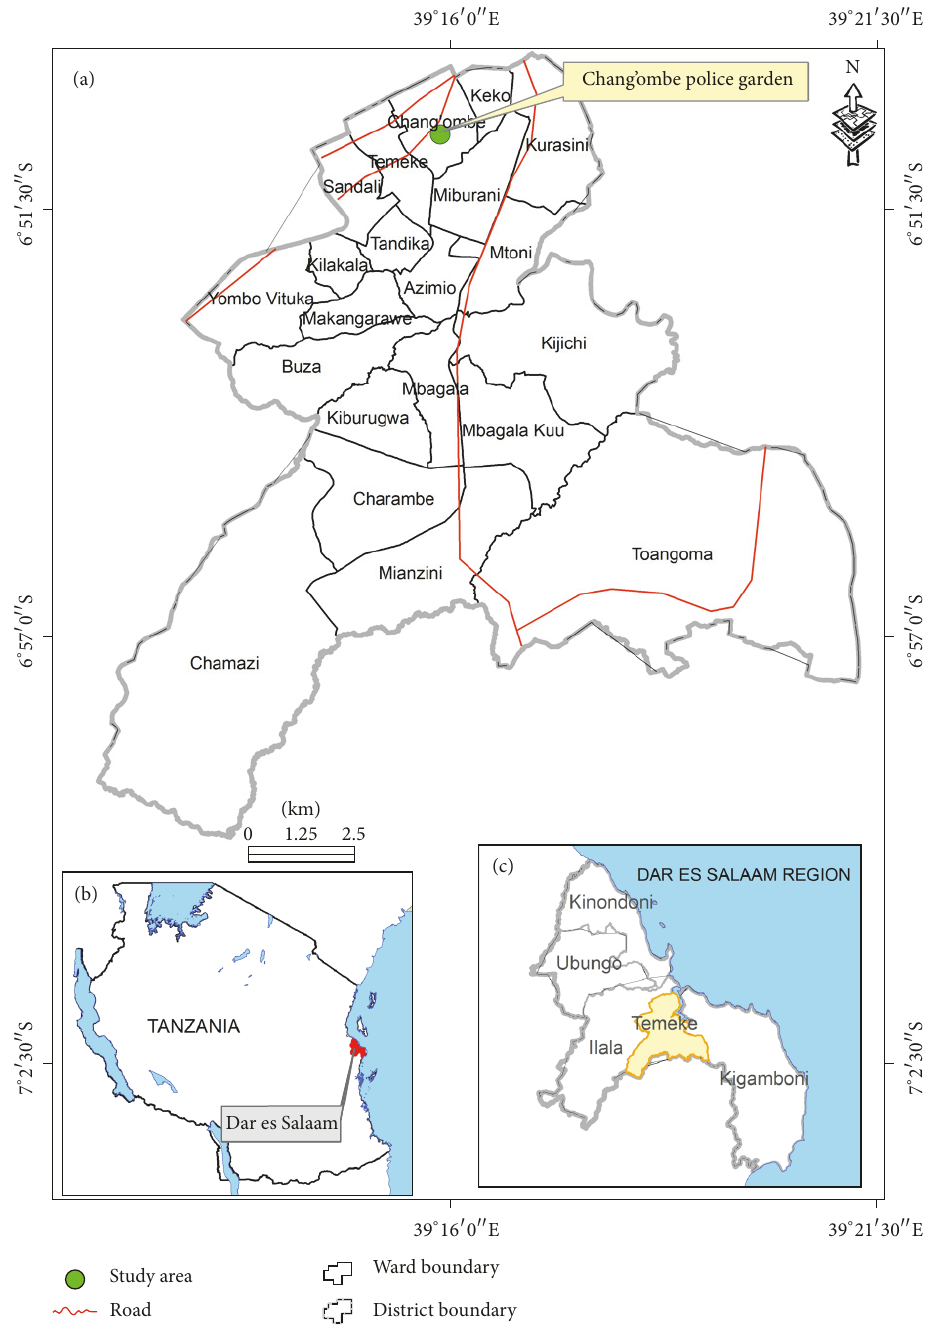
Figure 1: (a) The location of the study area in Temeke municipality; (b) location of Dar es Salaam region in Tanzania; and (c) the location of Temeke district in Dar es Salaam